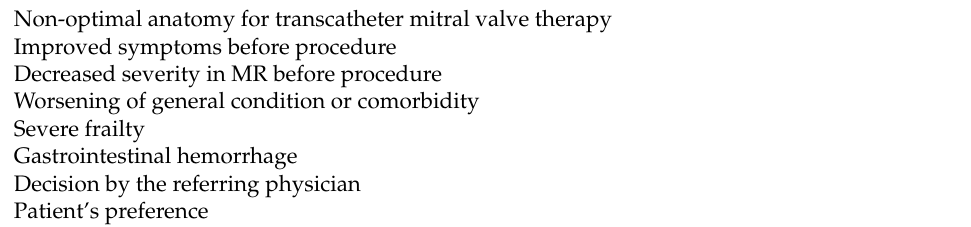
Figure 5. Representative cases of non-eligible valve morphologies for TMVR. Red arrows indicate severe mitral annular calcification ( a ). White curved outline and white arrows illustrate small neo- LVOT area. Blue curved line shape shows simulated transcatheter heart valve ( b ). Abbreviations: LVOT, left ventricular outflow tract and TMVR, transcatheter mitral valve replacement. Table 4. Reasons for medical therapy alone.